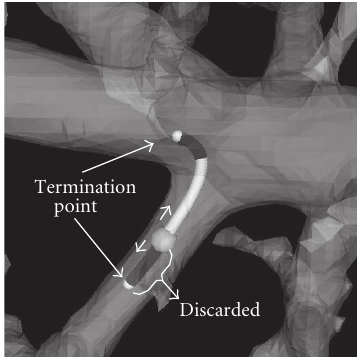
Figure 4: An illustration of the tracking process from a thin segment. The seed point is shown by a gray sphere. At the seed point, the tracking front can take both e 3 or − e 3 as the initial direction. Either way, tracking will be terminated after λ 3 changes its sign twice and becomes a positive value. The sign of λ 3 becomes negative before the front reaches a junction center. To ensure that the branch is reconnected by tracking, the process needs to wait until the sign changes twice—which indicates that the front truly passed through the junction area. Then the intensity value at the termination points is examined and either trajectory whose intensity value at the termination point is less than the other will be discarded. The other will be used for boundary recovery with the radius